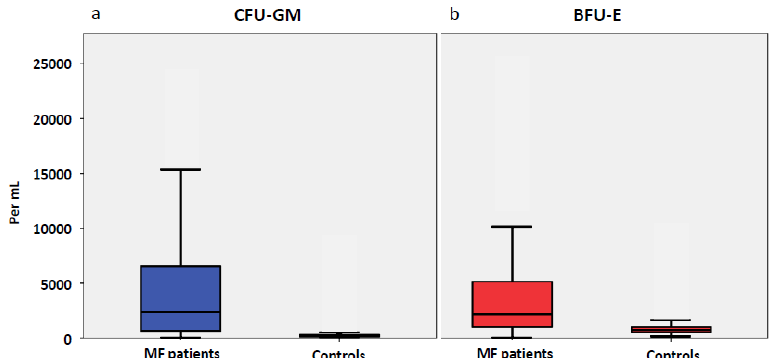
Figure 1. Box plots showing the distribution of circulating colony-forming units- granulocyte / macrophage (CFU-GM) ( a ) and burst-forming units-erythroid (BFU-E) ( b ) in patients with myelofibrosis and normal controls including median values, minimum values, maximum values, as well as upper and lower quartiles, respectively. Cultures were plated in duplicates at 100 × 10 3 peripheral blood mononuclear cells (PBMNC) / mL. Aggregates with more than 40 translucent, dispersed cells were counted as